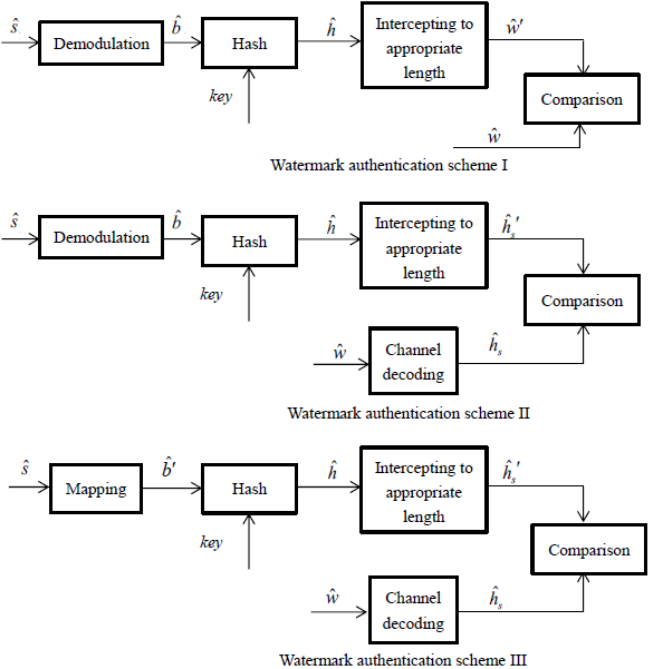
Figure 8. Watermark authentication schemes for scheme I, scheme II and scheme III.